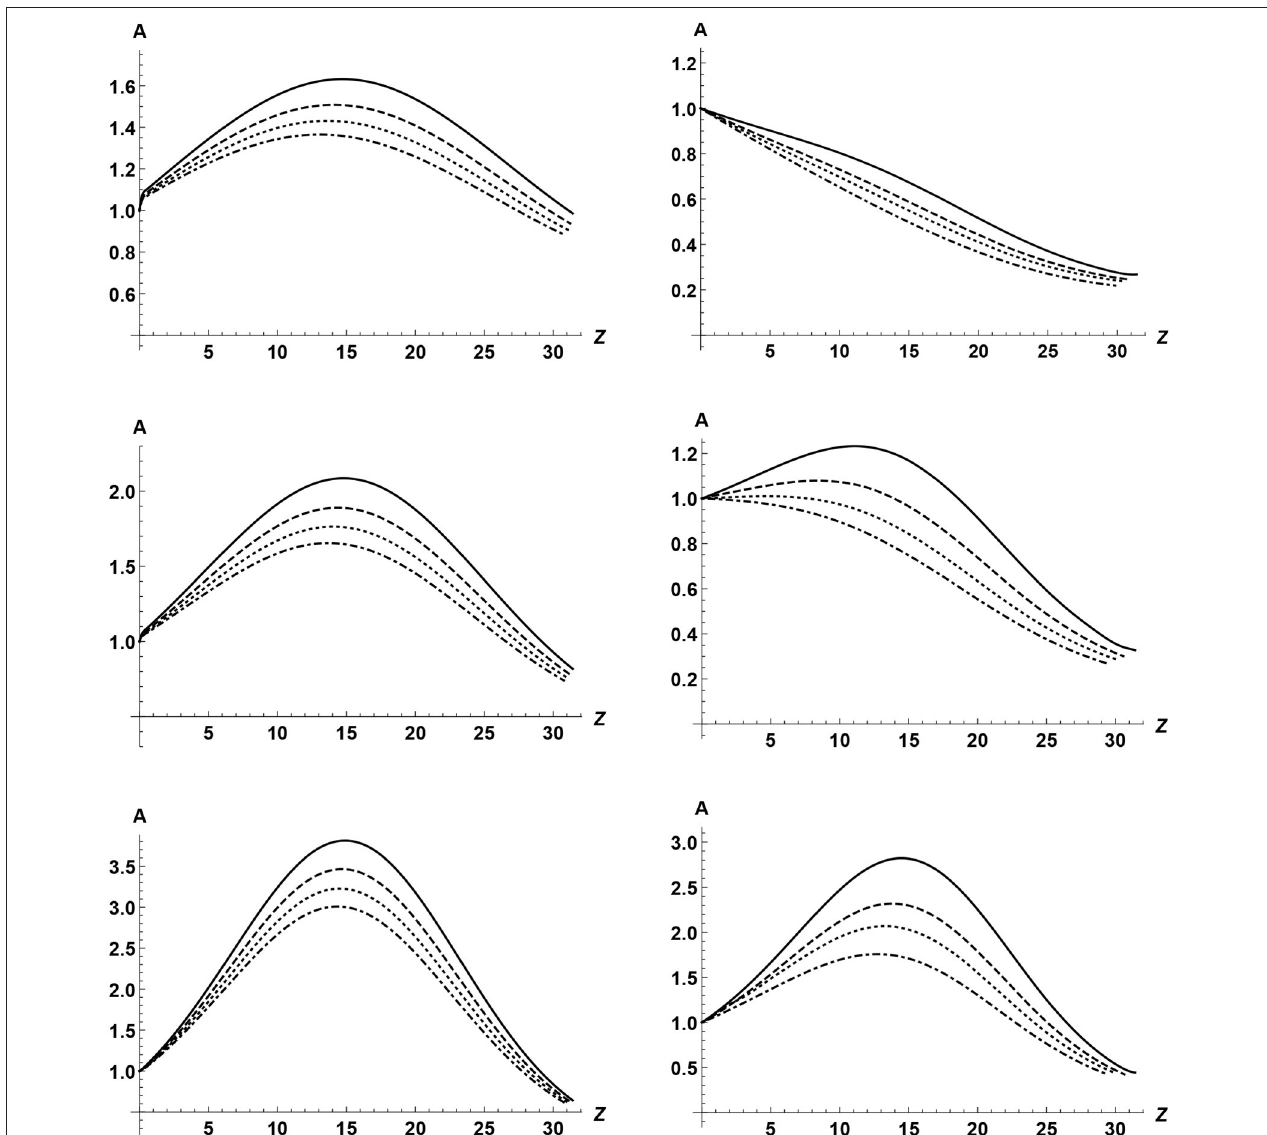
t end . The left panels correspond to λ =